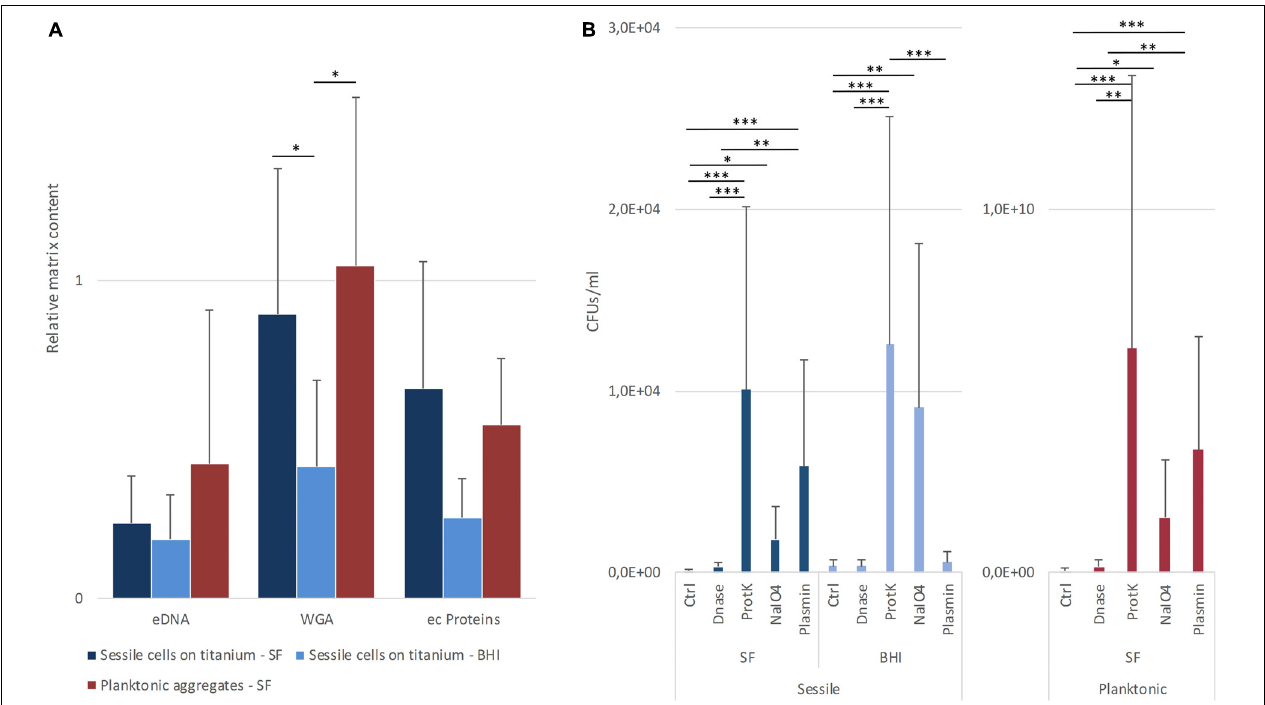
FIGURE 6 | (A) Relative content of matrix components in sessile and planktonic cells grown in lab medium (BHI) or in synovial fluids (SF). The data reported are the average of three distinct acquisitions of three replicates for each strain. (B) Estimation of aggregate dispersion based on the measurement of increased colony forming units (CFU). Four replicas for each treatment were performed for each strain. * p < 0.05, ** p < 0.01, and *** p < 0.001.